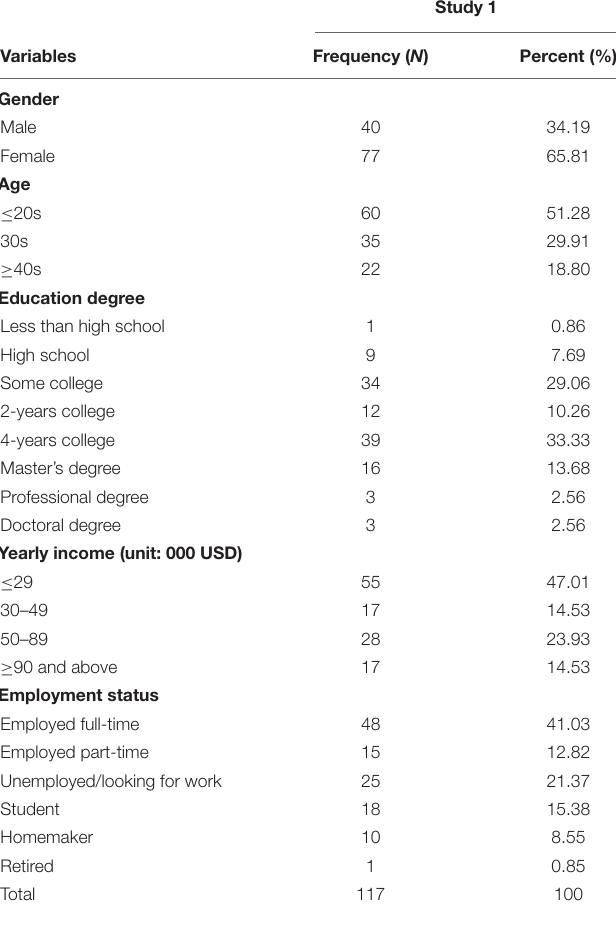
TABLE 1 | Sample demographic for study